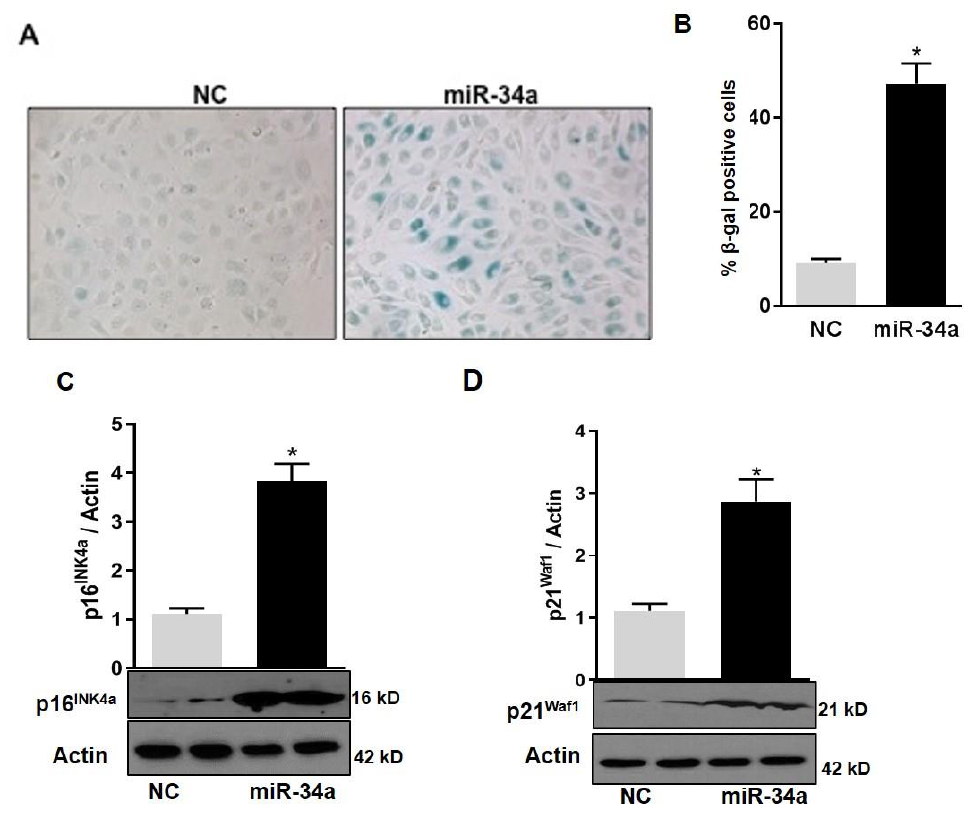
Figure 7. MiR-34a overexpression induces senescence in HuREC. ( A ) Micro images showing SA- β -Gal staining (blue cells) in HuREC transfected with miR-34a mimic or negative control for 48 h. ( B ) Bar histograms representing percentage of SA- β -Gal positive HuREC (per field) transfected with miR-34a mimic (black bar) or negative control (dark gray bar) for 48 h. Ten consecutive fields per sample were counted in a blinded fashion. Immunoblotting analysis determining protein levels of ( C ) p16 INK4a and ( D ) p21 Waf1 in HuREC transfected with miR-34a mimic (black bar) or negative control (dark gray bar) for 48 h. Changes in protein levels are expressed (bar histograms) as band density normalized versus actin. Bars represent mean value ± S.E.M; * p < 0.05 vs . NC, n = 4.